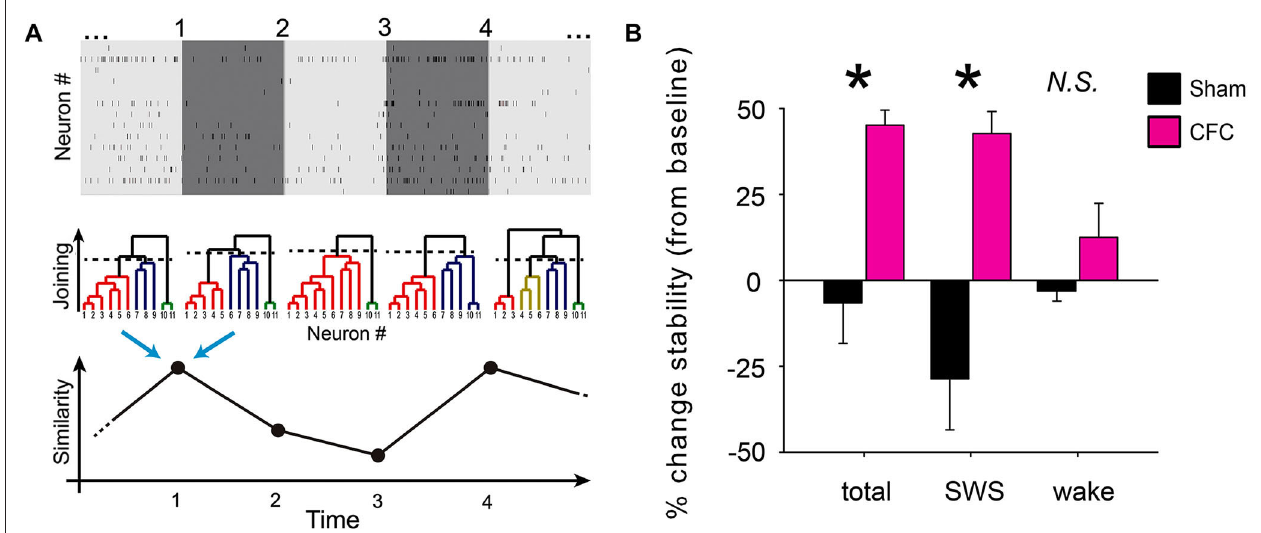
consecutive intervals (bottom). (B) Minute-to-minute network stability was averaged across baseline to post-conditioning periods. Post-conditioning changes in average stability (from baseline) are shown for Sham and CFC mice. While significant differences in stability changes were seen between the two groups when analysis was carried out across all states (total) or across intervals occurring in SWS, no significant stability differences seen for analysis over intervals of wakefulness (wake). * indicates p < 0.01 and p < 0.005 respectively for all-state and SWS-specific analysis, Student’s t